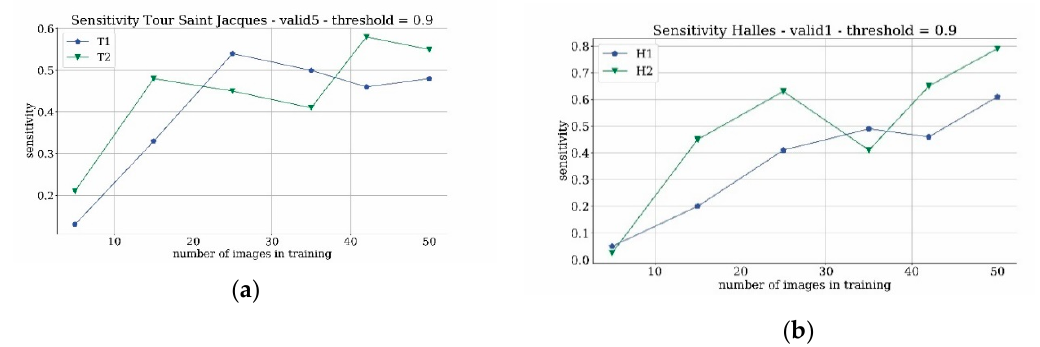
Figure 16. Real values of sensitivity analysis: ( a ) for T1 and T2 with valid5 and threshold equal to 0.9; ( b ) for H1 and H2 with valid1 and threshold equal to 0.9.